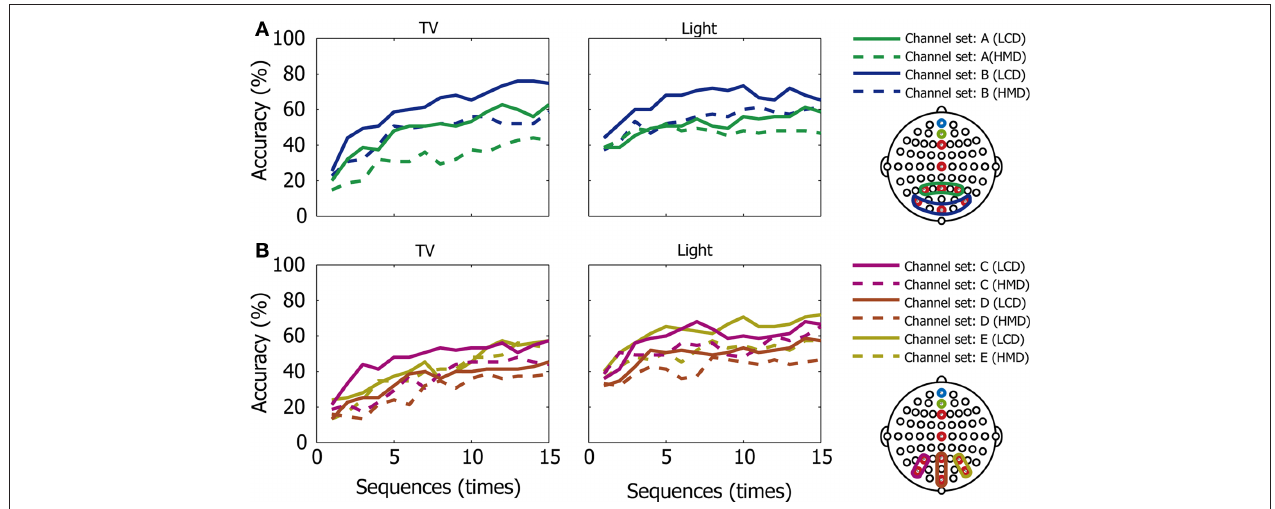
FIgure 4 | Control accuracy in the channel sets. Accuracy in controlling the TV and desk light are shown in different channel sets (A–E). The horizontal axes indicate the number of sequences, while the vertical axes indicate the accuracy. (A) : channel